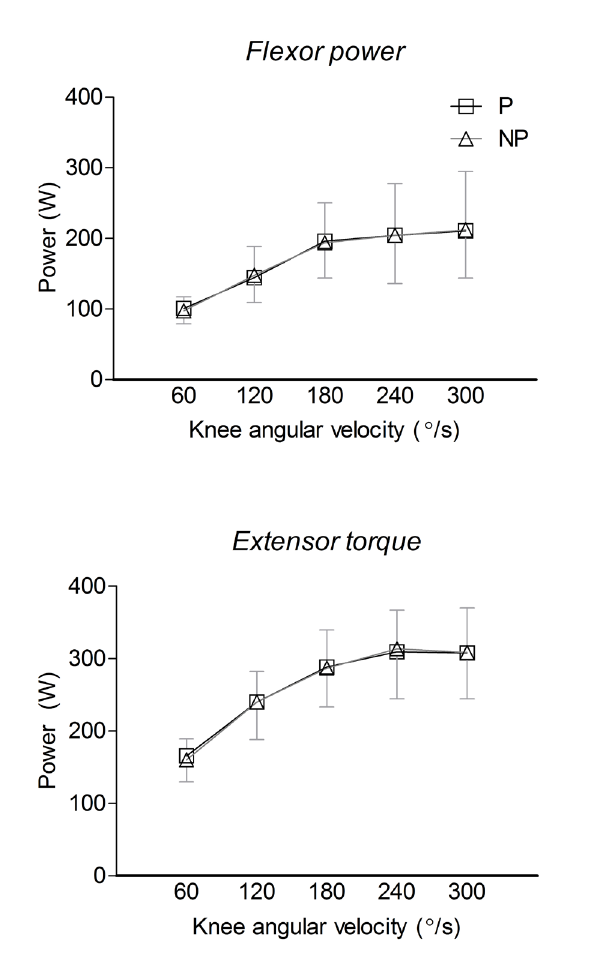
Figure 4. Flexor (top) and extensor (bottom) power output during isokinetic contractions at different contraction